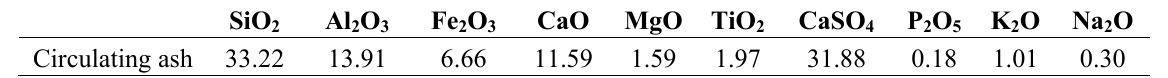
Table 1. Compositions of circulating ash from a CFB boiler (%). Circulating